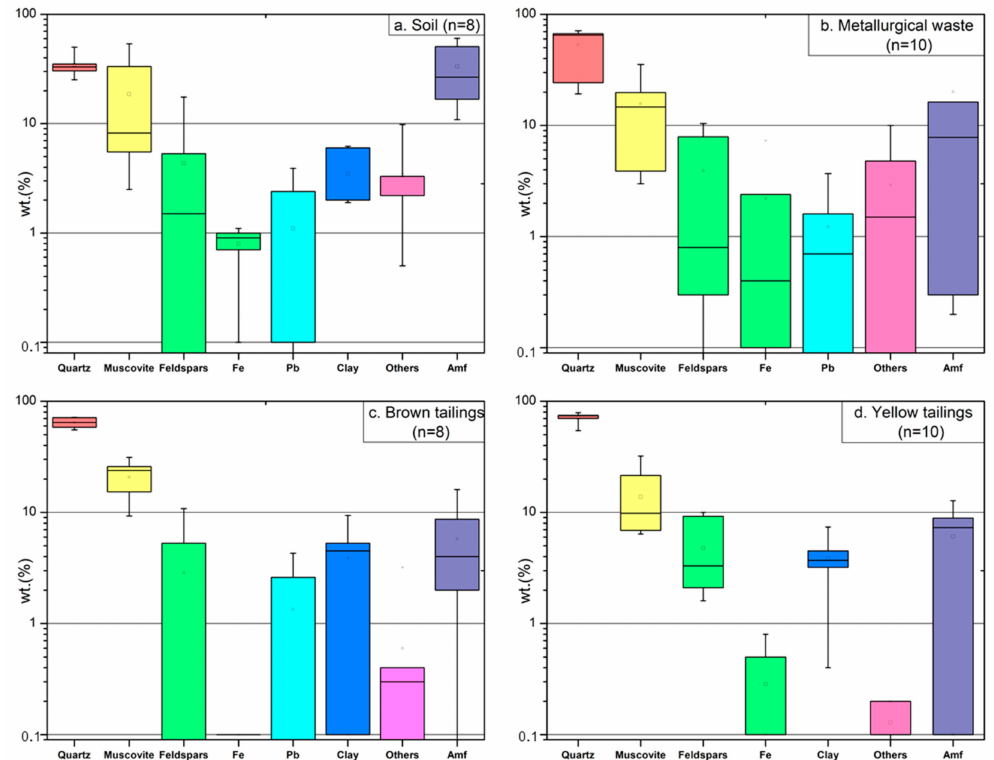
Figure 8. Whisker plots of the mineralogical composition for different anthropogenic units identified at Plombi è res: ( a ) soil, ( b ) metallurgical waste, ( c ) brown tailings, ( d ) yellow tailings. Fe—iron minerals (goethite, lepidocrocite); Pb—lead minerals (galena, anglesite and plumbogummite), others—chlorite, rutile, titanite and cristobalite, Amf—amorphous